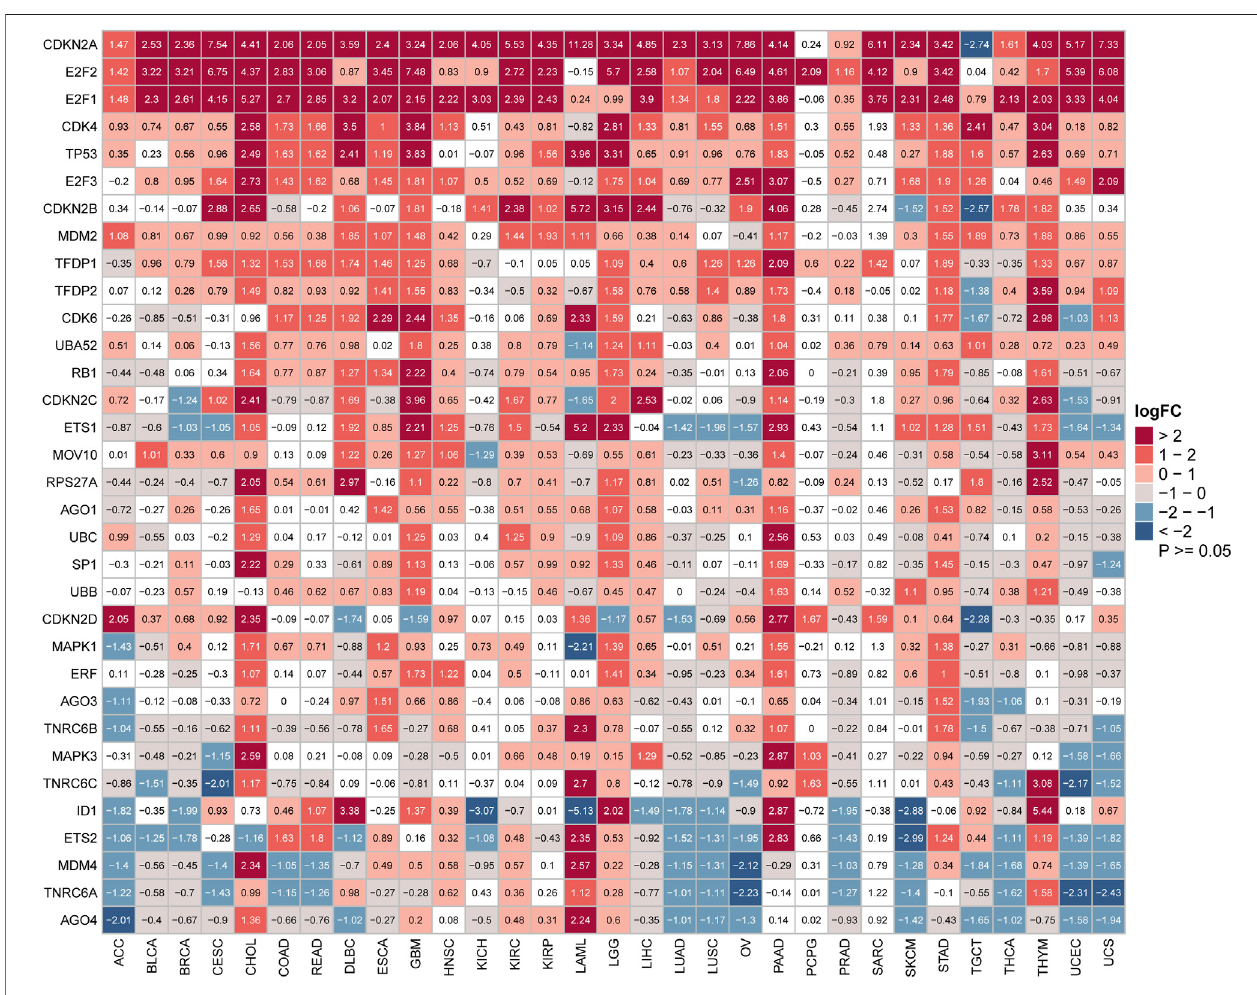
FIGURE 2 | Aberrant expression of senescence-related genes in cancers. Heatmap showing the mRNA difference of senescence gene set between the Cancer GenomeAtlas(TCGA)tumorsamplesandnormaltissuesamplesfromTCGAandGenotype-TissueExpression.UpregulatedgeneshavelogFC > 0,anddownregulated genes have logFC < 0. ( p < 0.05 was considered to be signi fi cant. FC: fold